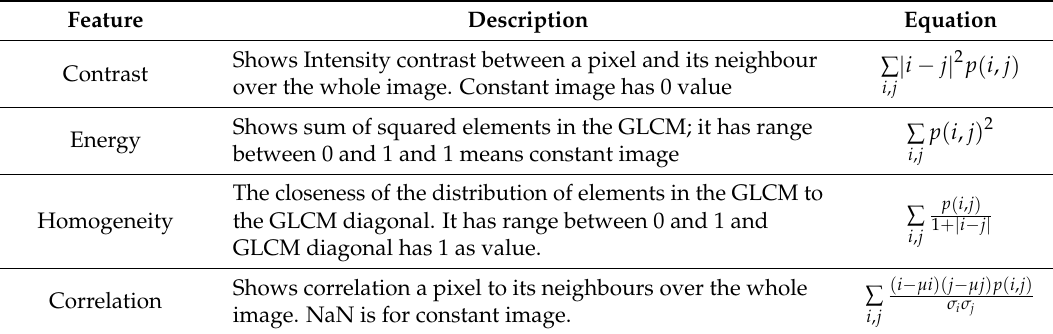
Table 3. Texture